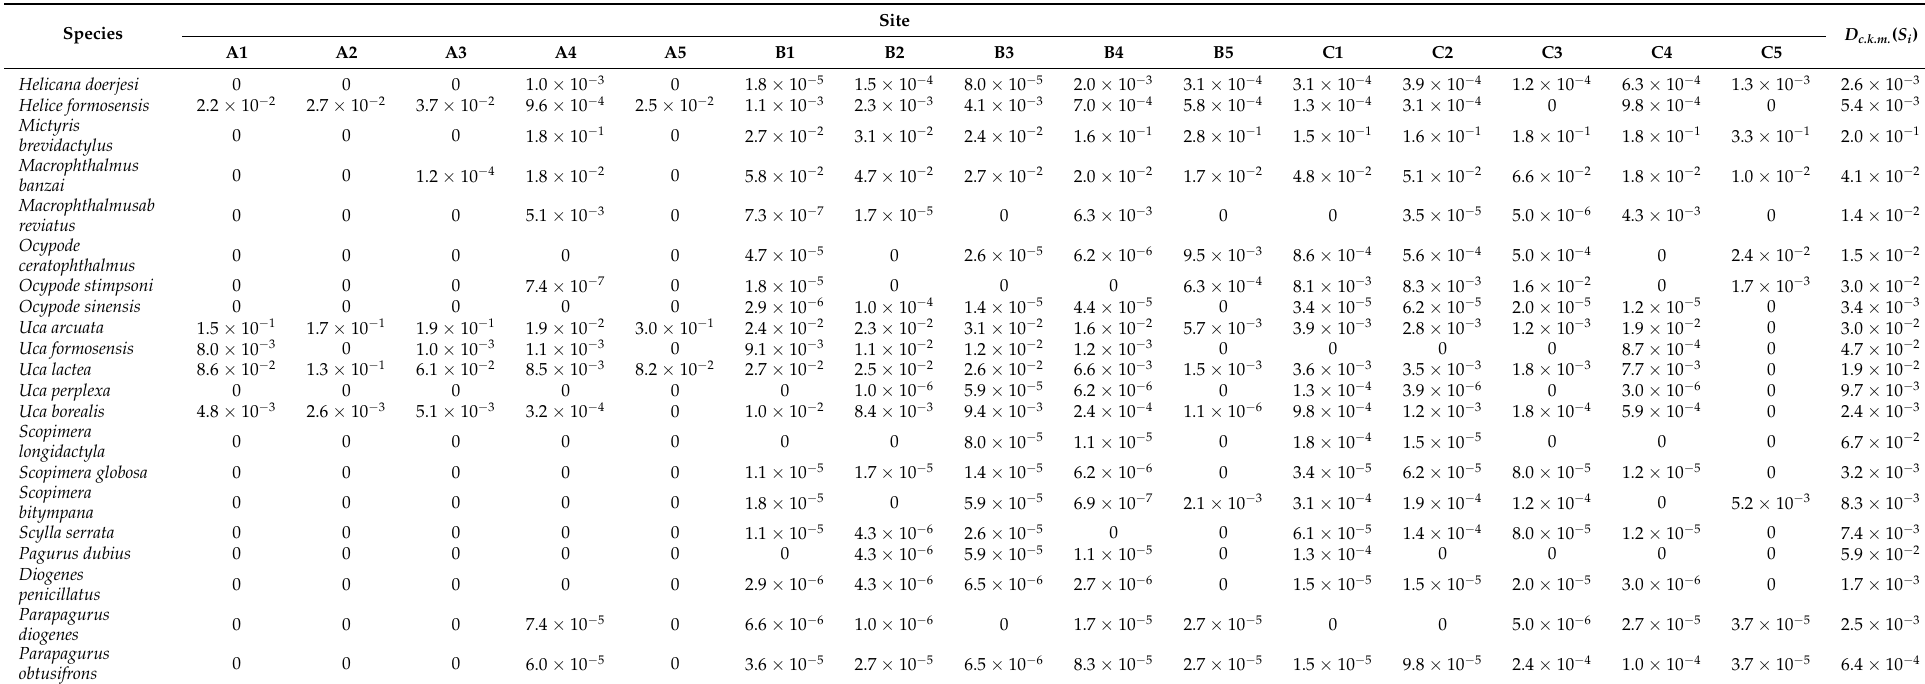
Table A6. Probabilities of ( D c.k.m. ) at different